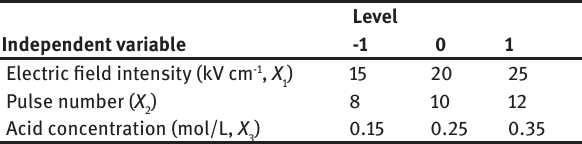
Table 1: Experimental range and levels of the independent variables used for Box-Behnken rotatable design.